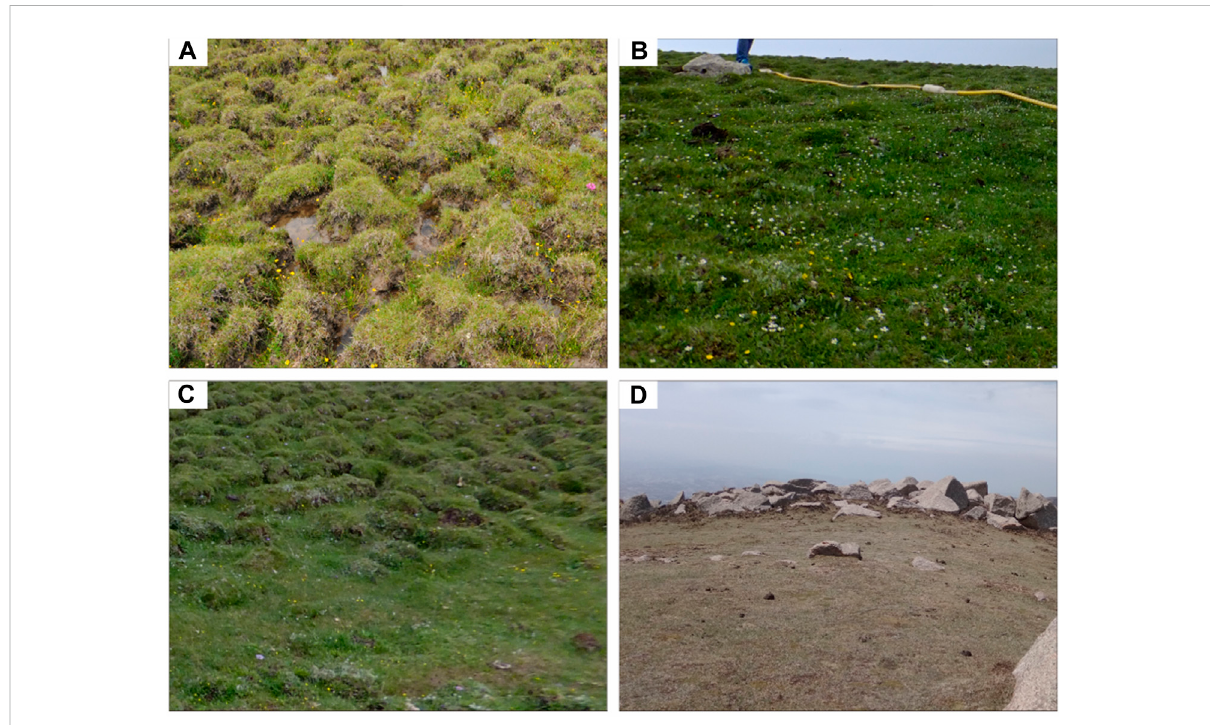
FIGURE 10 Photos of surface vegetation in the Mahan Mountain area. (A) In the permafrost region, shot at location a in Figure 11. (B) Non-permafrost region,shotatlocationbinFigure11. (C) Degradedpermafrostregion,shotatlocationcinFigure11. (D) Bedrockexposedarea,shotatthetopofthe